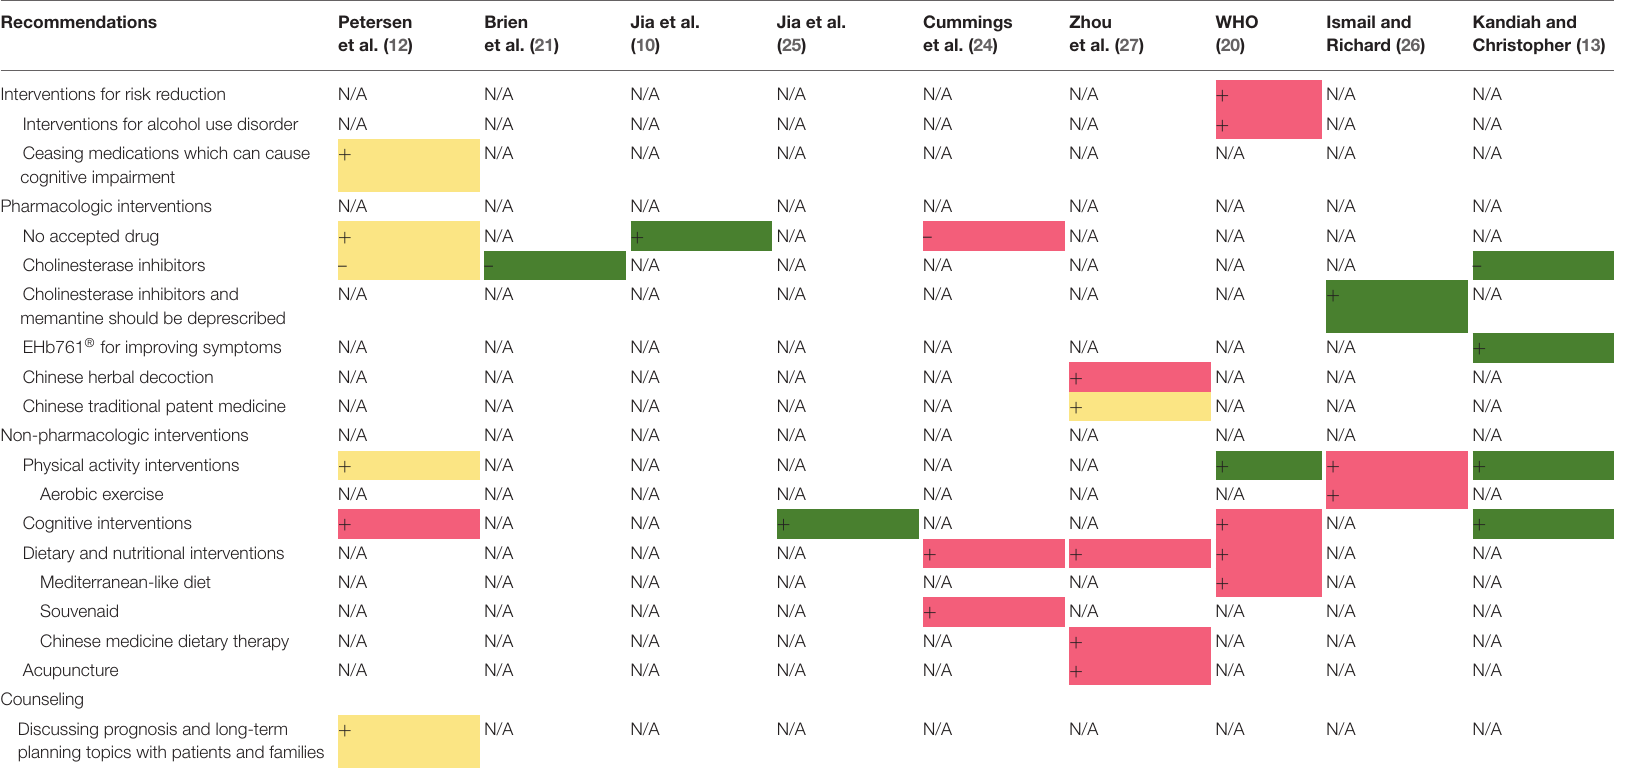
TABLE 4 | Summary of recommendations for treatment and